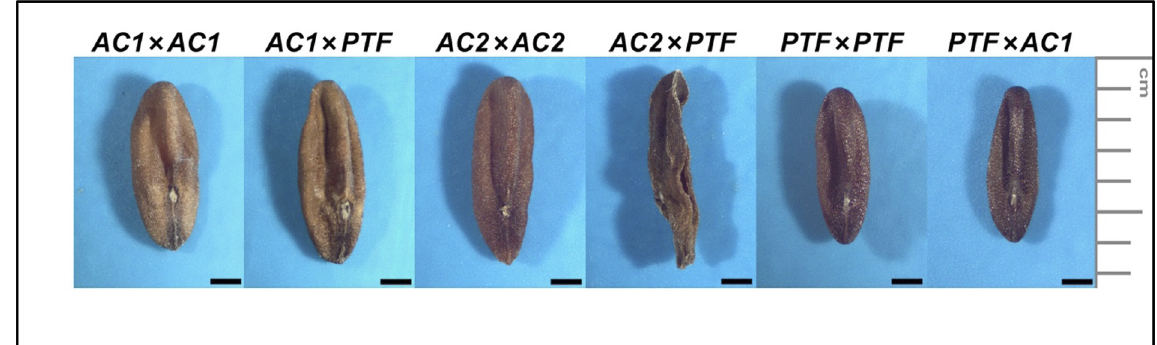
Fig. 2: Morphology of seeds deriving from selfings (control) and interspecific crossings, scale bar: 1